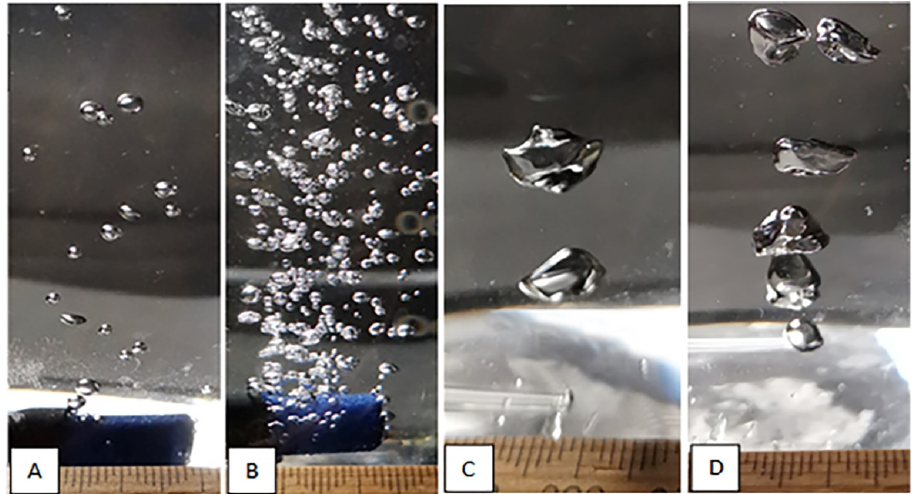
Figure 2. Air bubbles used in the experiments. ( A ) Small bubbles at 0.01 L/min, ( B ) small bubbles at 1.0 L/min, ( C ) large bubbles at 0.25 L/min and ( D ) large bubbles at 0.5 L/min. The concentration of airborne bacteria at different air flow rates is shown in Figure 3.